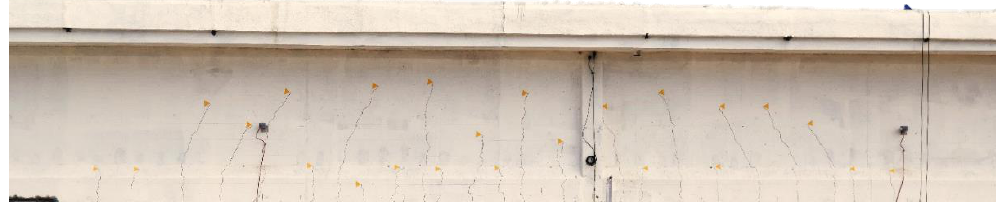
Figure 11. Visible cracks on girder T1 opened during the loading phase P3 4800 kN.